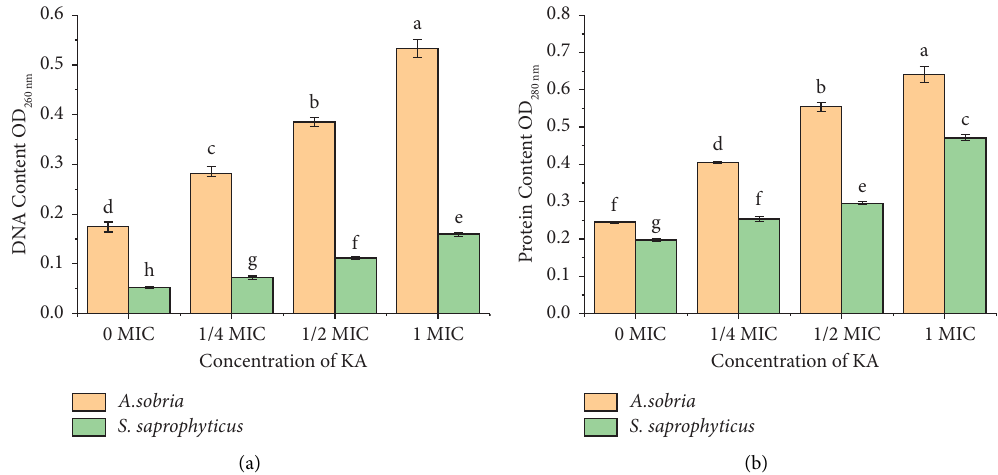
Figure 1: Te leakage of DNA (a) and protein (b) of A. sobria and S. saprophyticus after KA treatment at diferent densities at 30 ° C for 24h. Te diferent lowercase letters represent signifcant diferences ( P < 0.05).